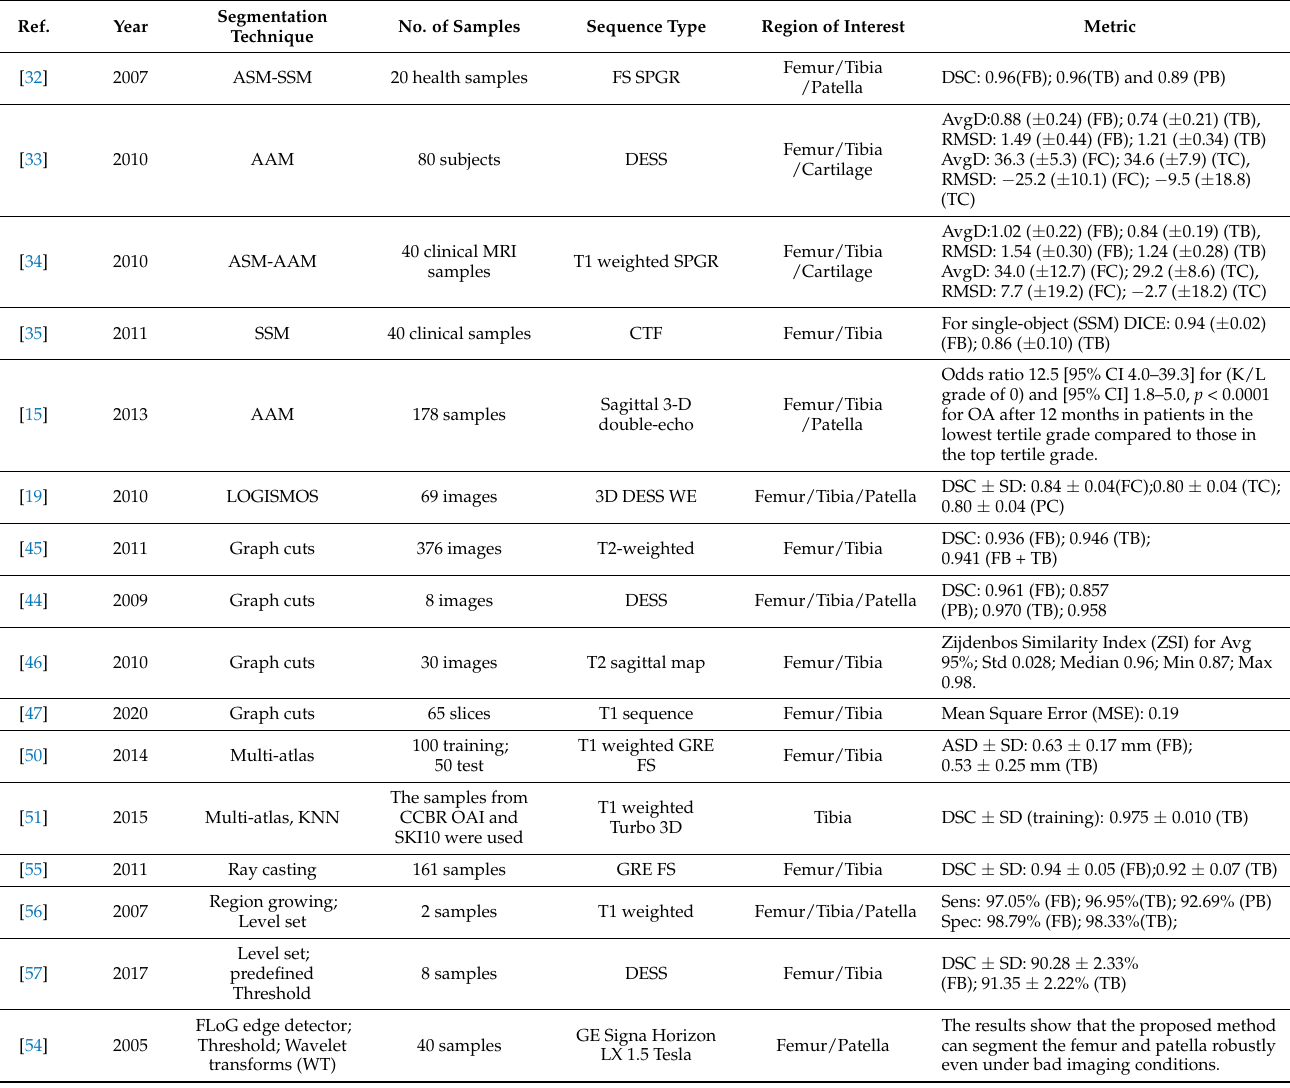
Table 1. Summary of automatic knee bone segmentation based on deformable, graph, atlas, miscella- neous models.